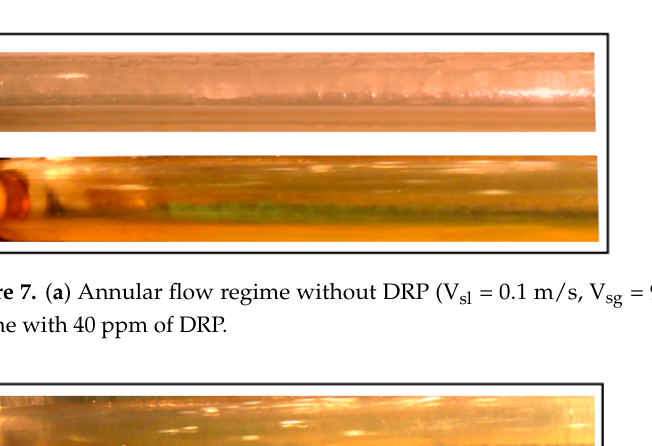
Figure 6. Effect of drag reducing polymer on annular flow regime.